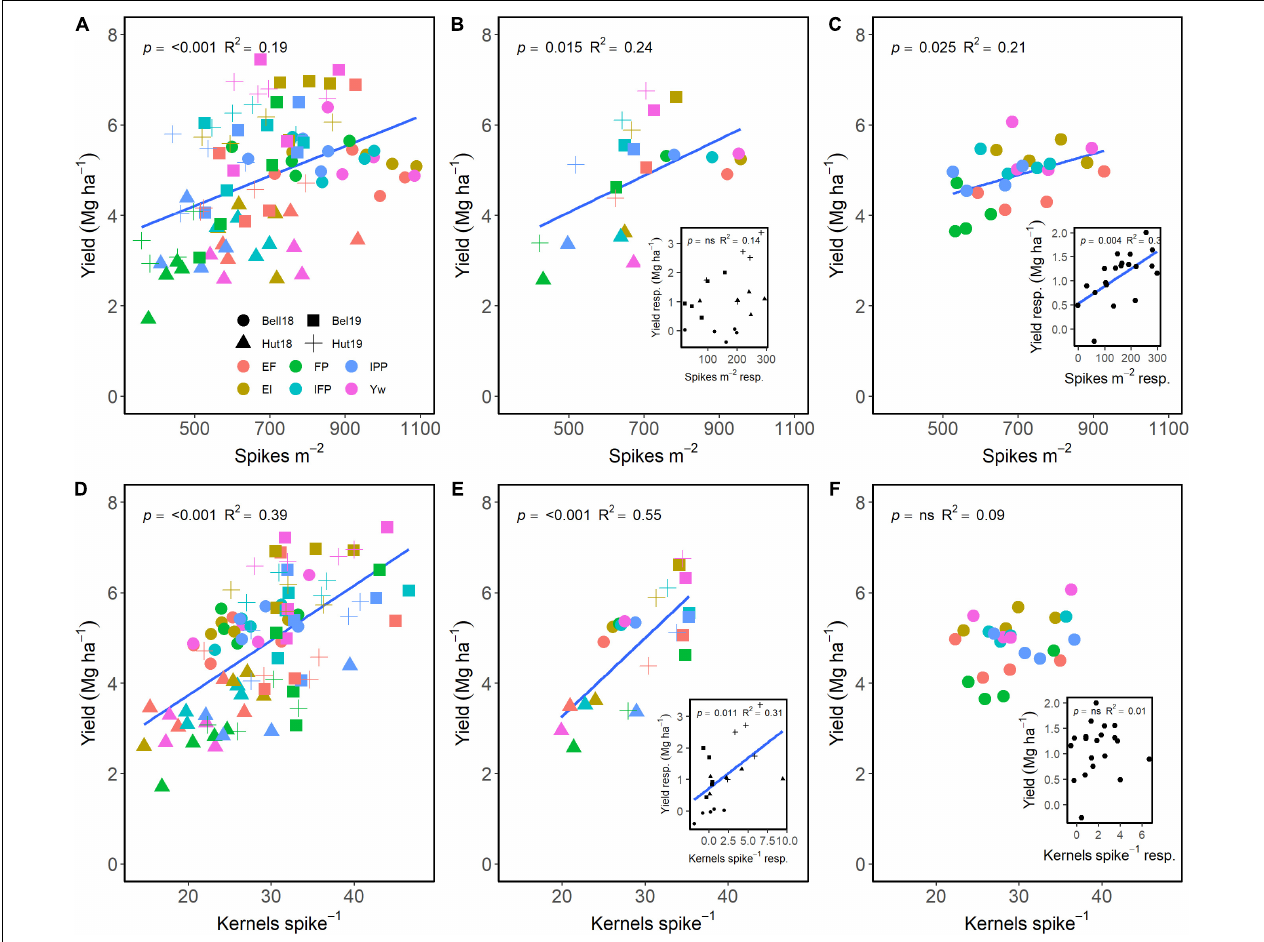
FIGURE 5 | Relationship between yield and spikes m − 2 (A–C) and kernels spike − 1 (D–F) across environments, wheat genotypes, and management systems ( n = 96) (A,D) , on average, each management for each environment ( n = 24; 6 management practices × 4 environments) (B,E) , on each genotype for each environment ( n = 24; 6 management practices × 4 genotypes) (C,F) . Inset graphs are the relationships between the responses of the variables to each management practice (difference between each management practice from the FP) averaged across either genotype for each management practice ( n = 20) or management for each environment ( n = 20) (C,F)